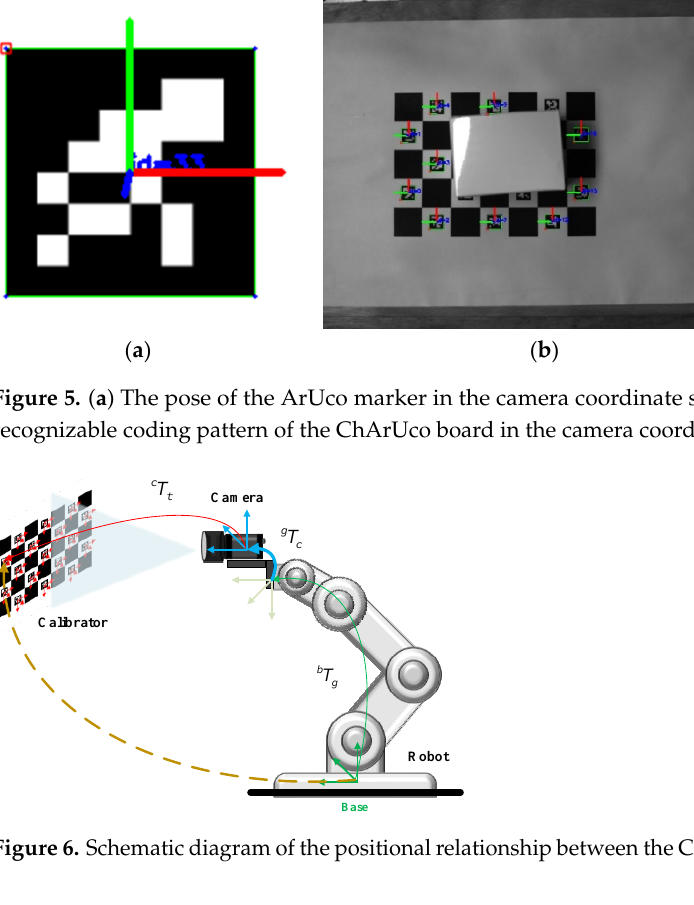
Figure 6. Schematic diagram of the positional relationship between the ChArUco board and the robot. Figure 7 shows the online hand–eye calibration process, based on the ChArUco board. Firstly, after the robot moved to the teaching posture, the camera captured the ChArUco board calibration image. Then, it was judged whether the position of the cali- bration board satisfied the condition by detecting the ChArUco board. If it was not satis- fied, the robot posture was automatically adjusted, according to the feedback of the ChArUco board position information, and the above steps were repeated. Otherwise, the data were saved, the posture of the robot adjusted, and the next teaching action was reached. When the collected hand–eye calibration data met the requirements, the hand– eye calibration matrix was solved.